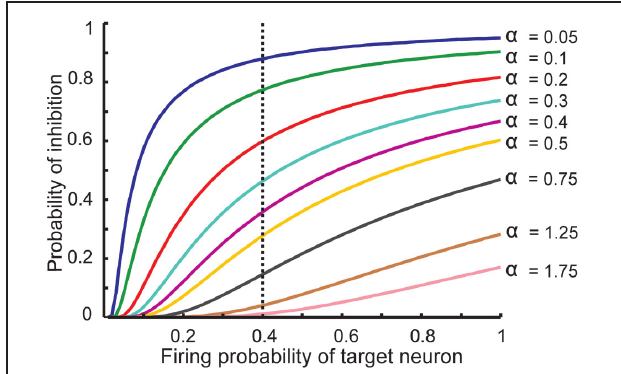
FIGURE 2 | The relationship between the probability of feedback inhibition and firing probability of the single neurons. For different parameter value ( α ), average firing probability of the single neurons elicits activity of inhibitory neuron. The vertical dash line shows the role of inhibition parameter for different inhibition intensity for average firing probability of single neurons equal to